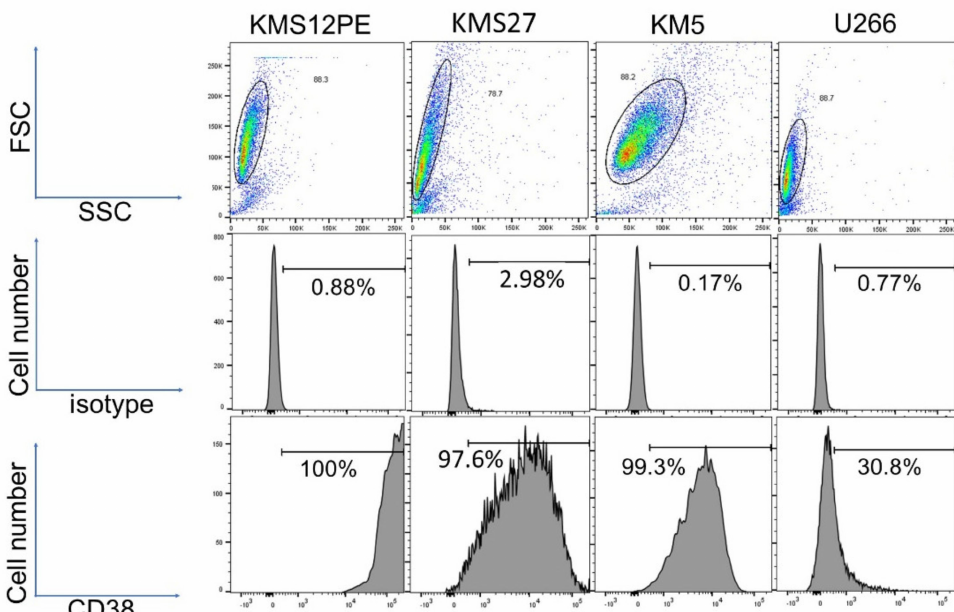
Figure 1. Flow cytometry for CD38 in MM cell lines. The upper panels show cytograms; the x-axis represents SSC and the y-axis represents FSC. The circled areas represent viable cells. The middle and lower panels show flow cytometry histograms. The x-axis shows the positivity for the antibodies and the y-axis represents the cell numbers. The middle panels indicate results with isotype control. The lower panels indicate results with Alexa 647-labeled CD38 antibody.